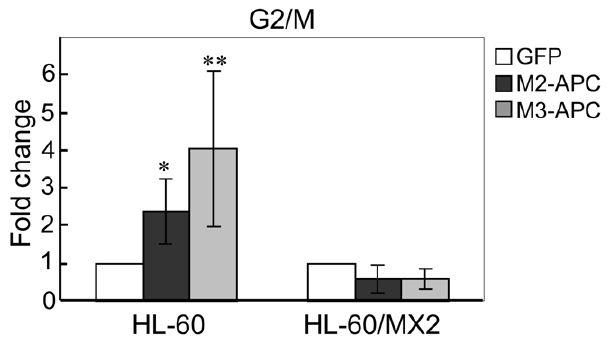
Figure 4. Expression of M2- or M3-APC results in G2/M accumulation in HL60 but not HL60/MX2 cells. Graph shows the G2/M population from HL-60 and HL-60/MX2 cells expressing EGFP-M2- orM3-APC for48 hours.ParentalHL60 cells exhibit a 2-foldincreasein